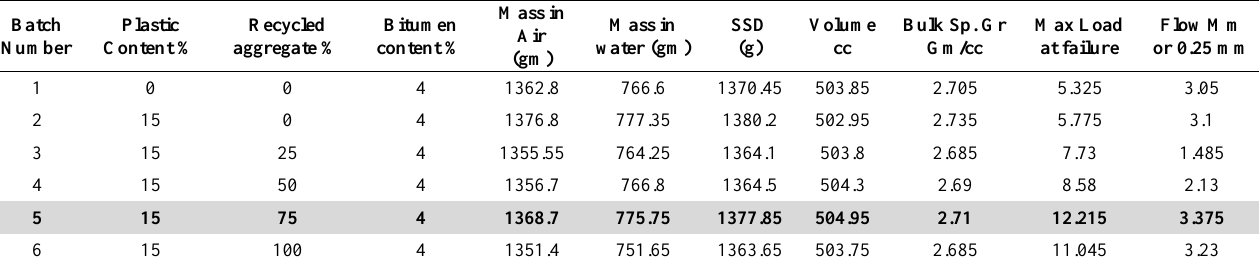
Table 7. Average results for all the